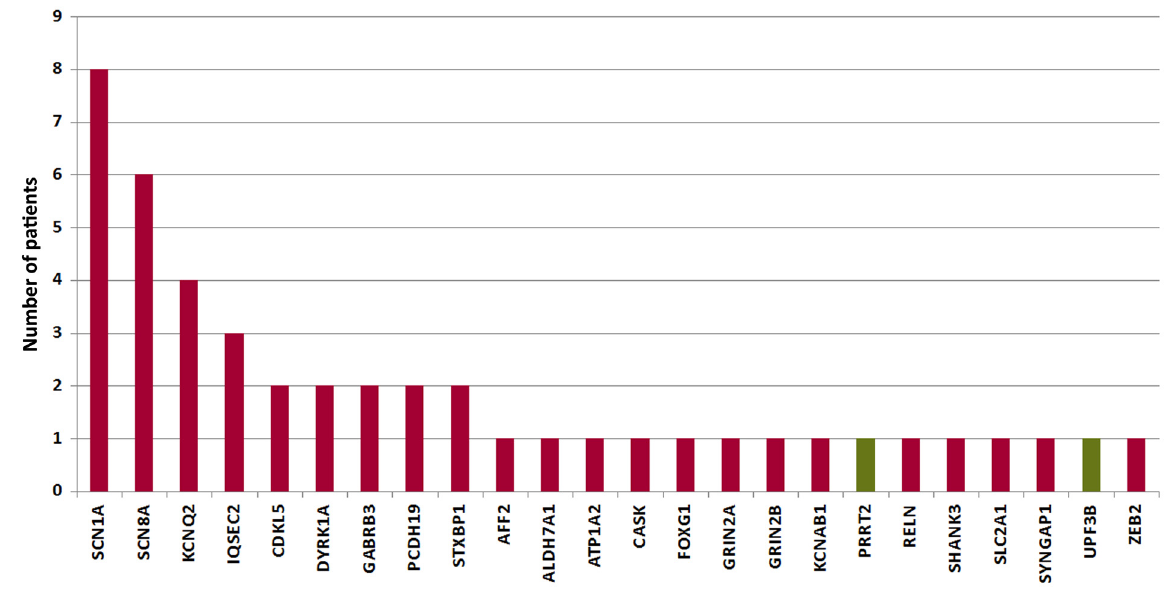
Fig 1. Pathogenic (red) and likely pathogenic (green) mutated genes identified in 253 patients with unexplained epilepsy and intellectual/ developmental disabilities.